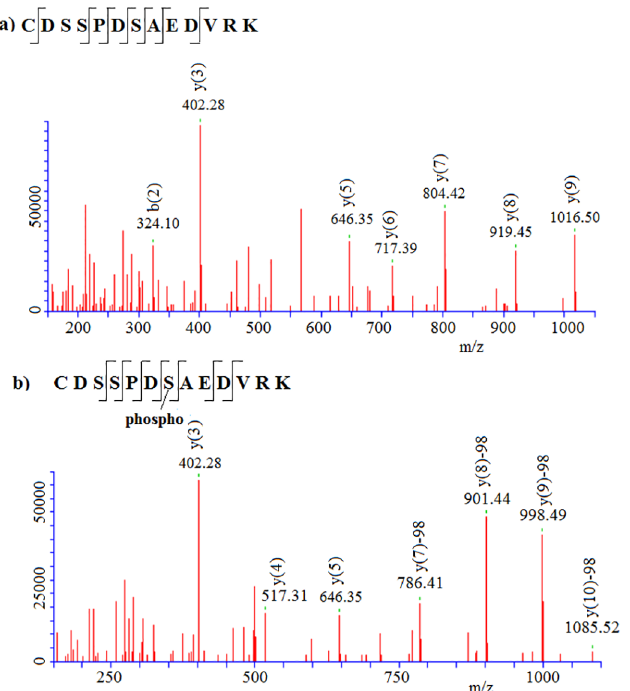
Fig 2. MS/MS spectraof non-modified (A) and phosphomodified (B) peptide DSSPDSAEDVR (2+) of alpha-2-HS-glycoprotein (FETUA_HUMAN) GBM plasma. Monoisotopic mass of neutral peptideMr (calc) 1,592.62. VariablemodificationS7–Phospho(ST) with neutral loss 97.98. [ y (10)] in a non-modified peptide was not